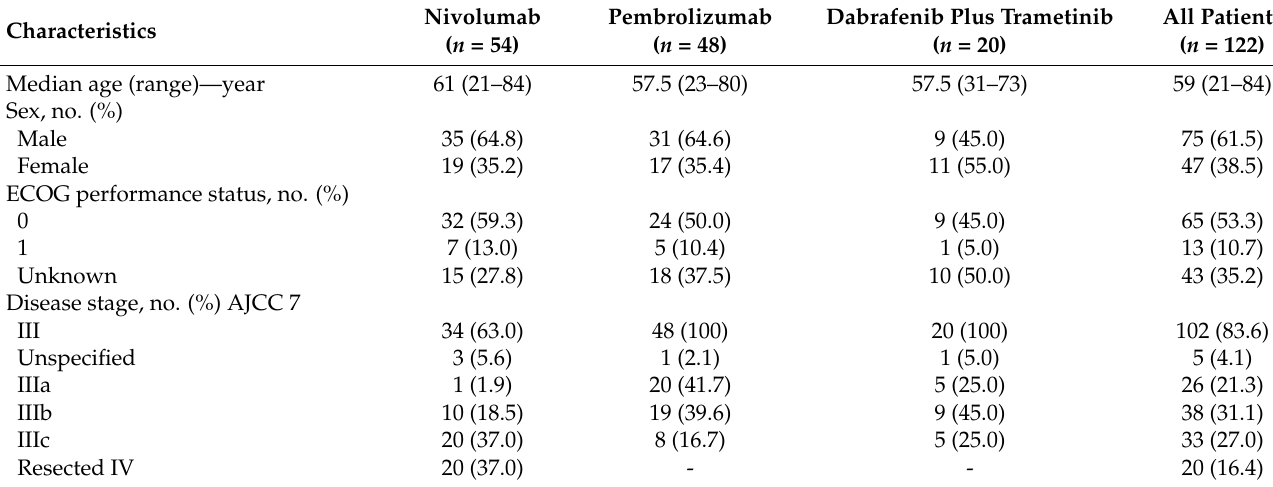
Table 2. Patient